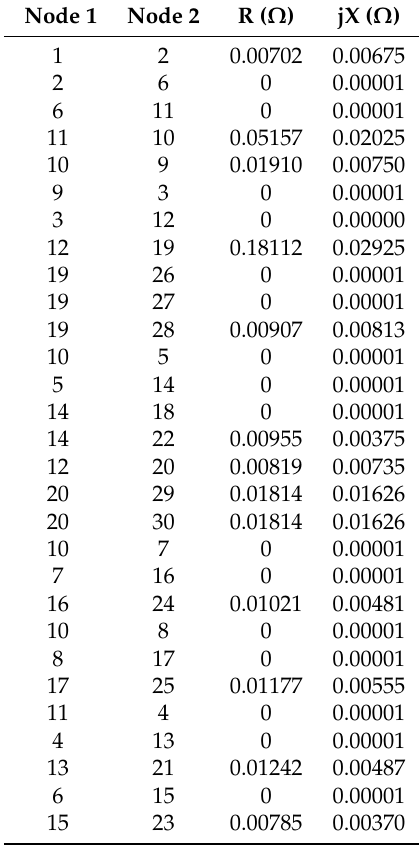
Table A1. Reactances of the system: Grid connected operation mode.